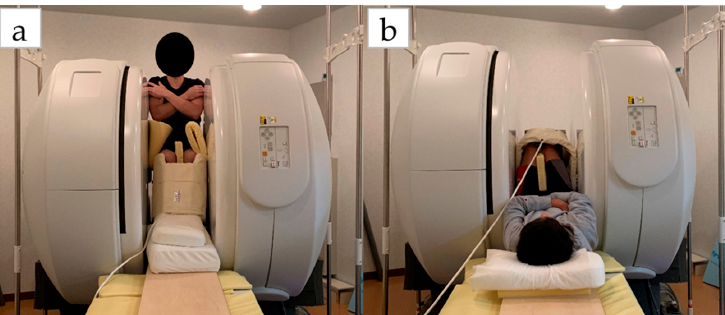
Figure 1. Measurement of position on vertical MRI: ( a ) sitting position; ( b ) lying position. Healthcare 2020 , 8 , x